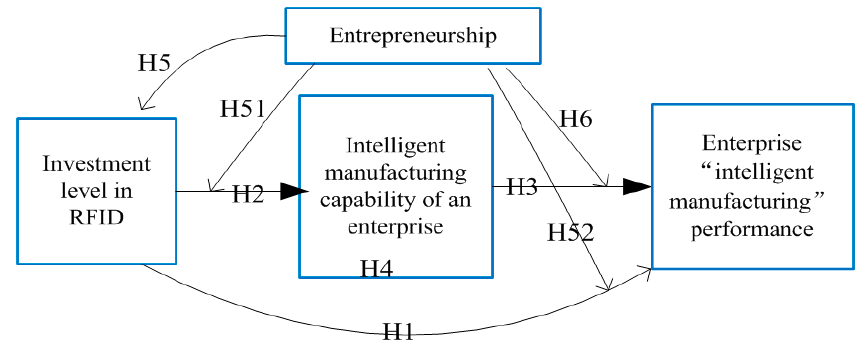
Figure 1. Conceptual Model.